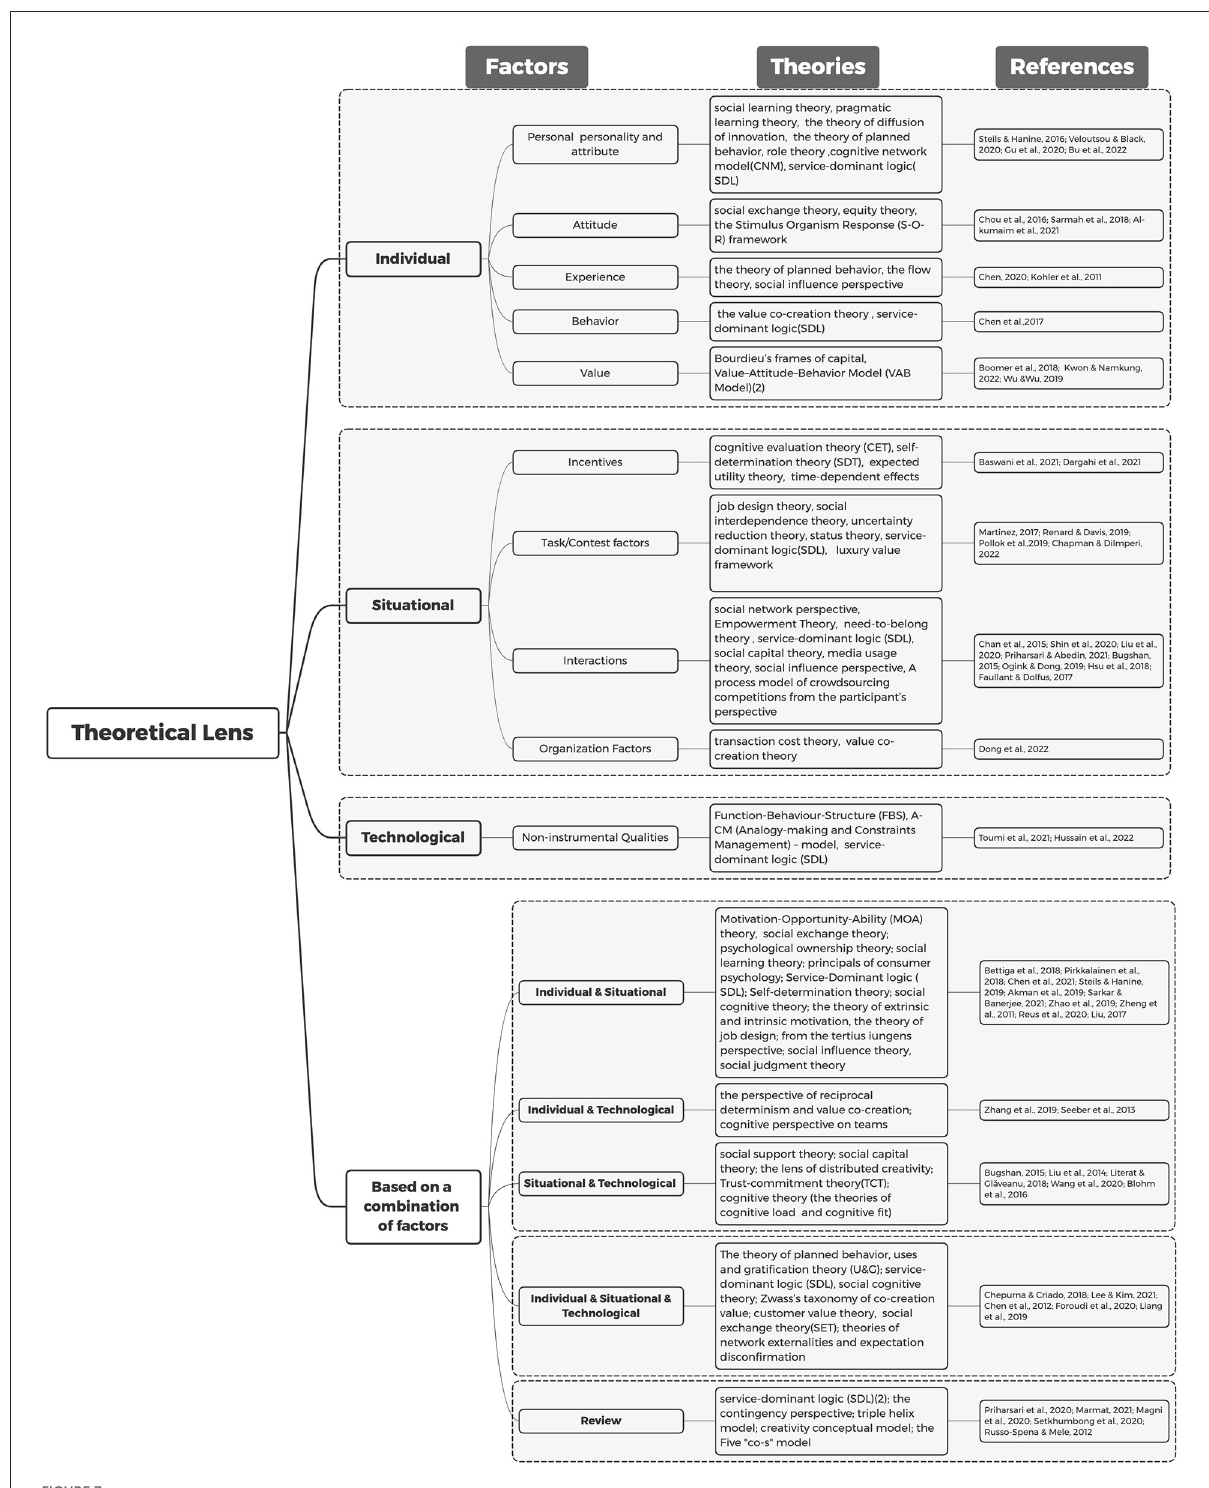
FIGURE7 Selected articles by theoretical lens and influencing